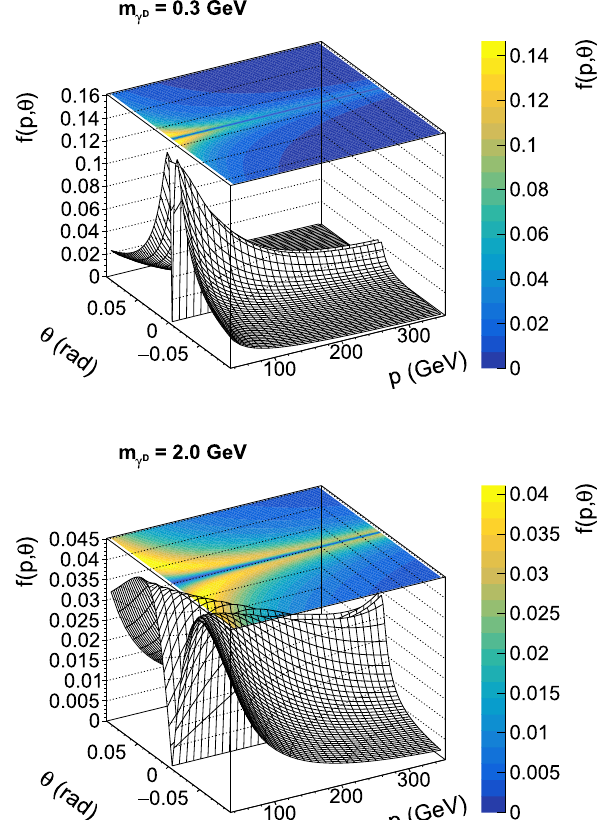
Fig. 3 Normalised probability density function of producing a dark photon with angle θ and momentum p through proton bremsstrahlung, for two representative examples of m γ D : 0.3 GeV (top) and 2 GeV (bottom)